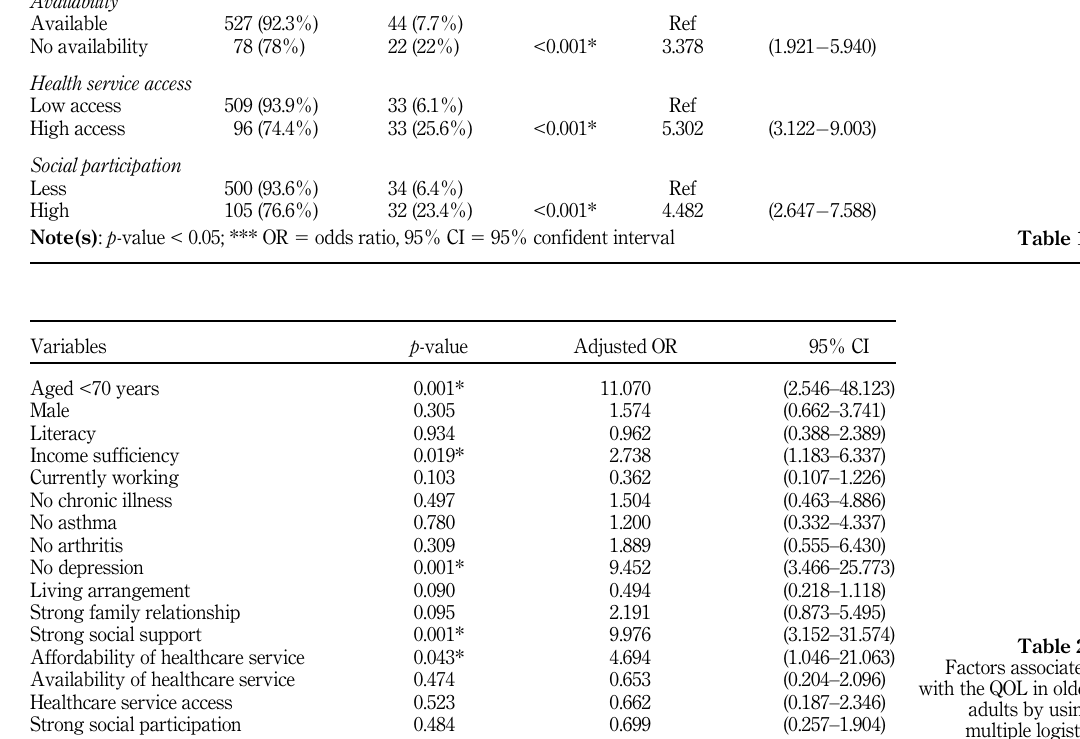
with the QOL in older adults by using multiple logistic regression